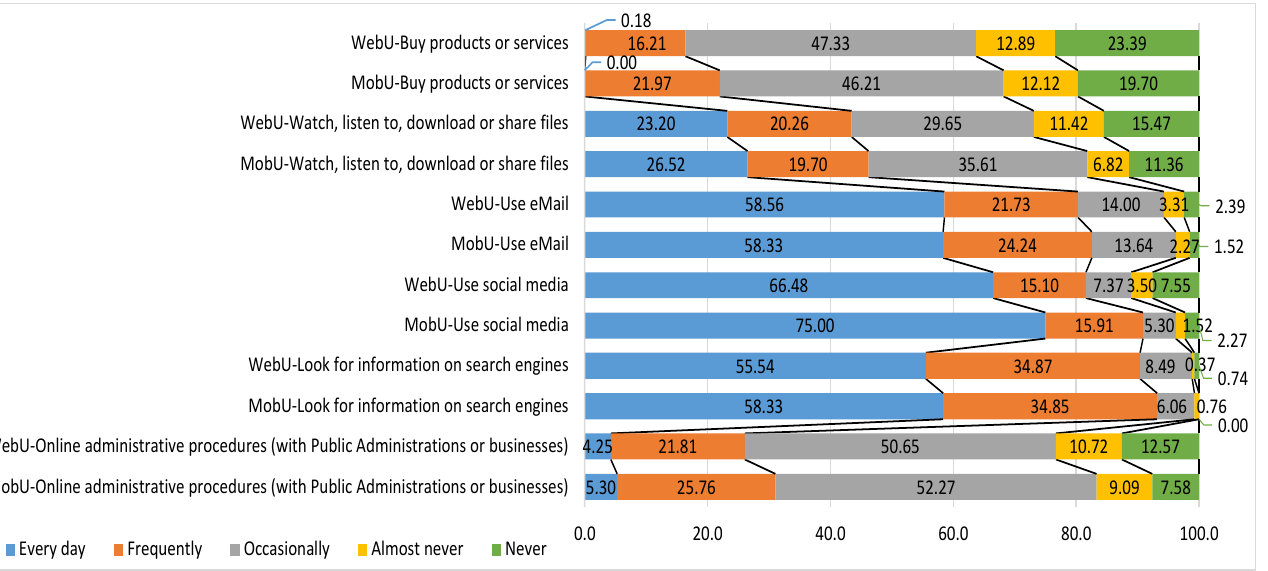
Figure 1. Basic online activities (by user profile).